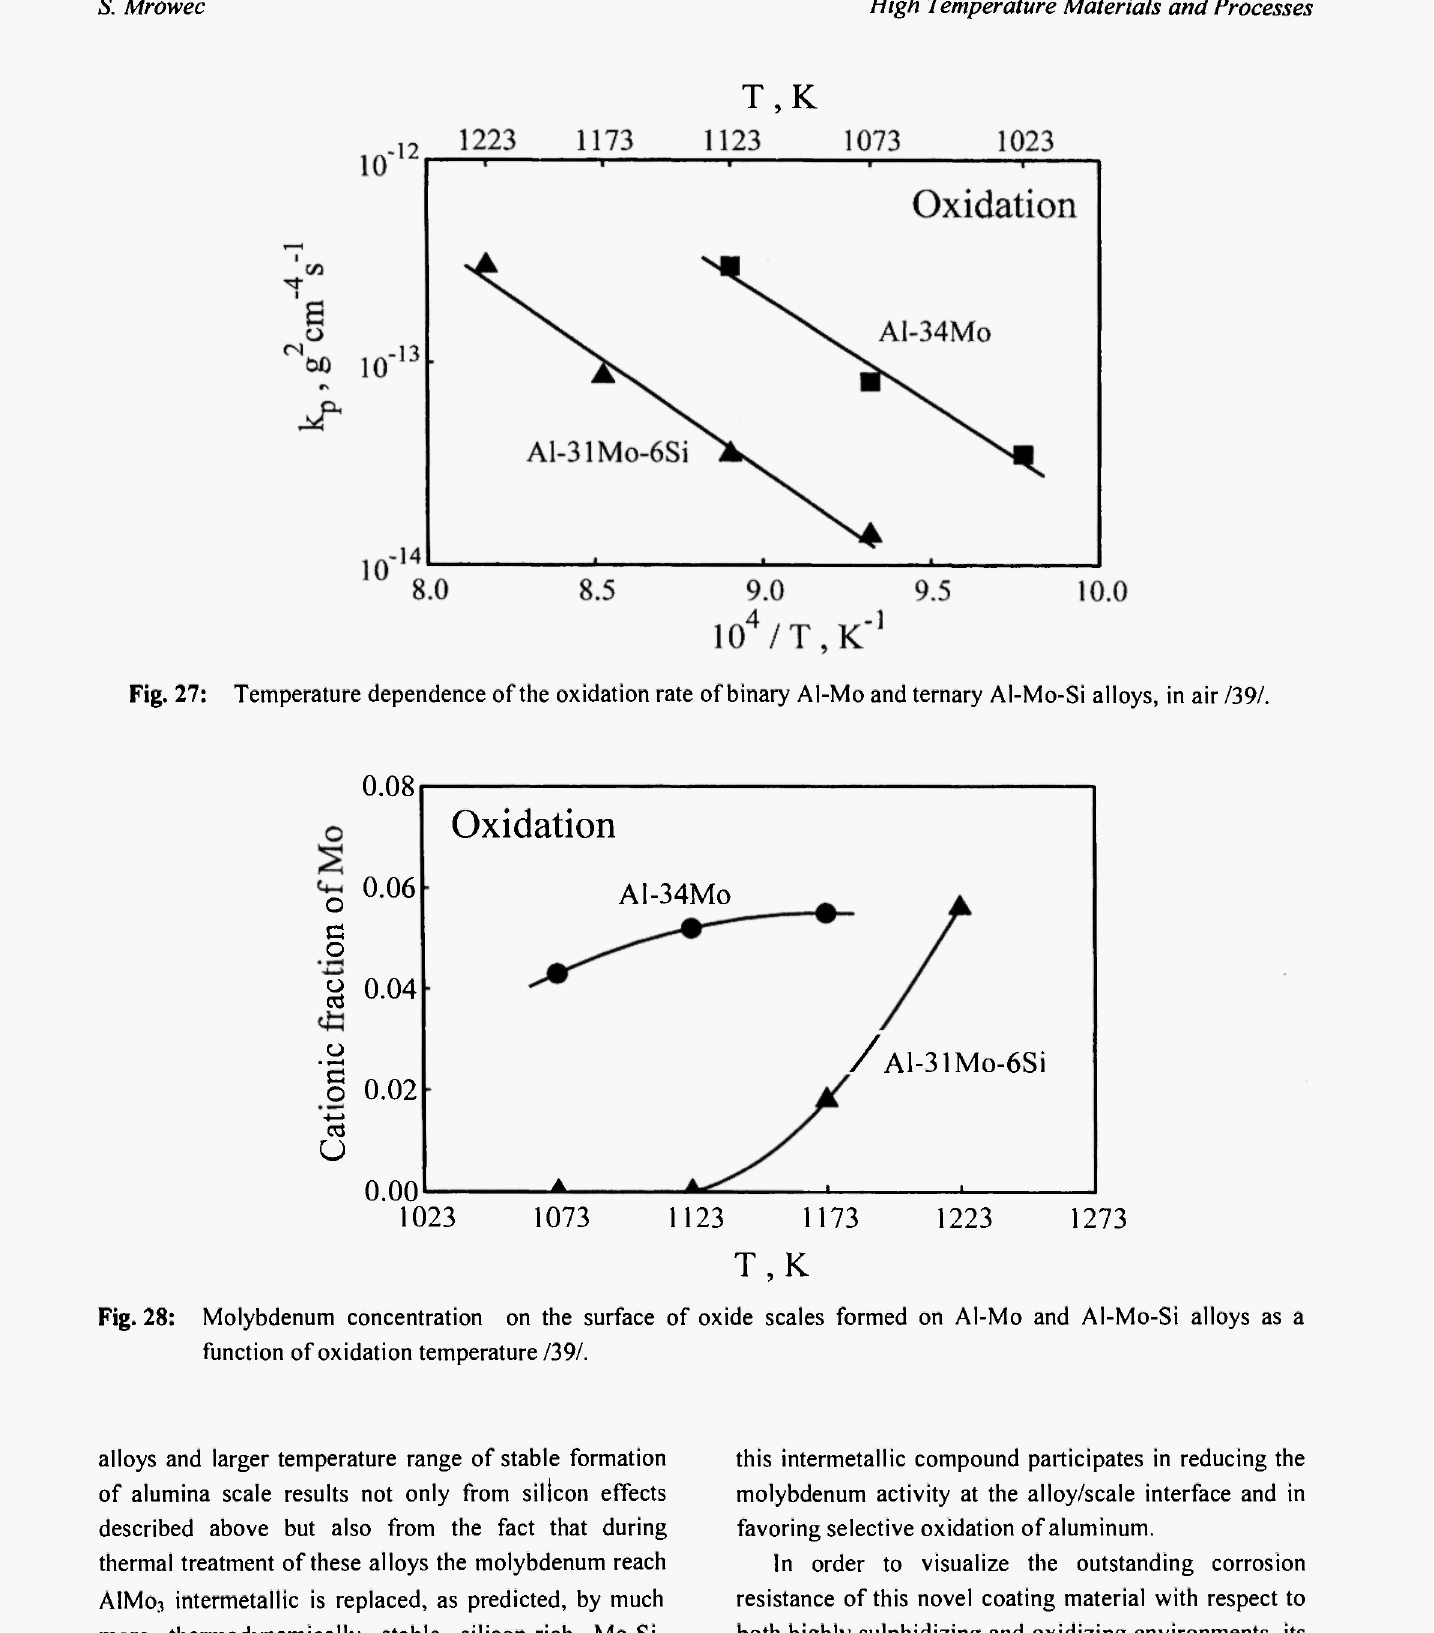
Fig. 28: Molybdenum concentration on the surface of oxide scales formed on Al-Mo and Al-Mo-Si alloys as a function of oxidation temperature